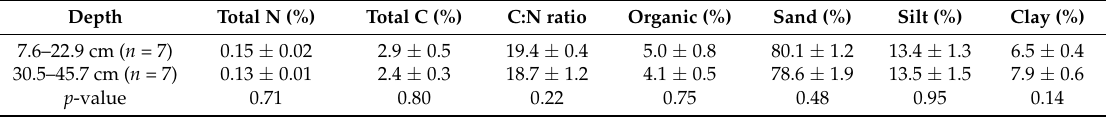
Table 2. Soil macronutrient and texture means ± standard error, and Wilcoxon rank-sum test p -values demonstrating lack of statistical difference ( p < 0.05) between shallow and deep